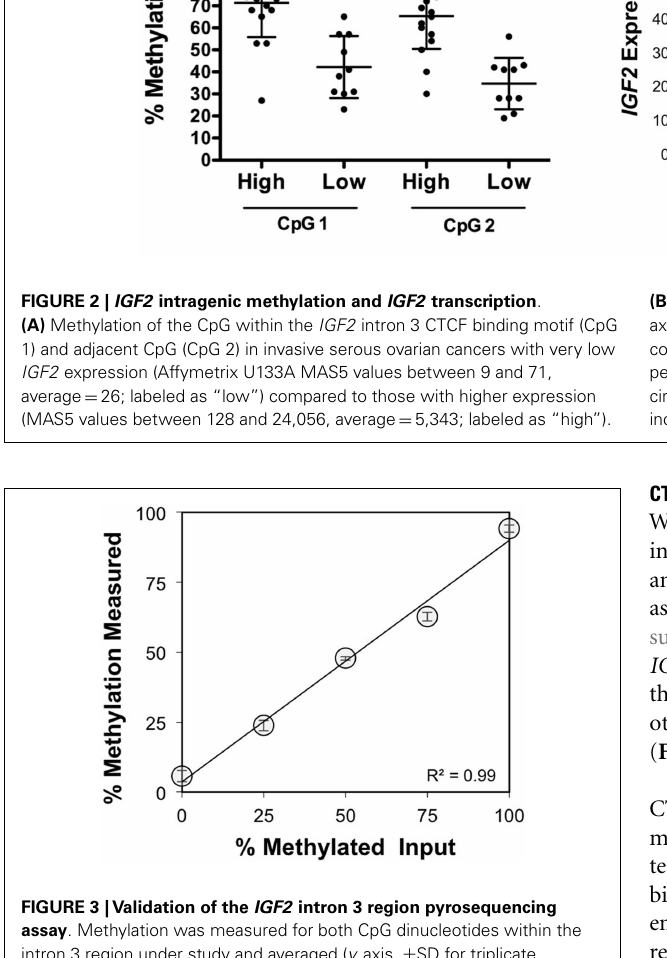
FIGURE 3 |Validation of the IGF2 intron 3 region pyrosequencing assay . Methylation was measured for both CpG dinucleotides within the intron 3 region under study and averaged ( y axis, ± SD for triplicate measures) for defined mixtures of plasmids ( x axis) containing the bisulfite modified methylated and unmethylated intron 3 region